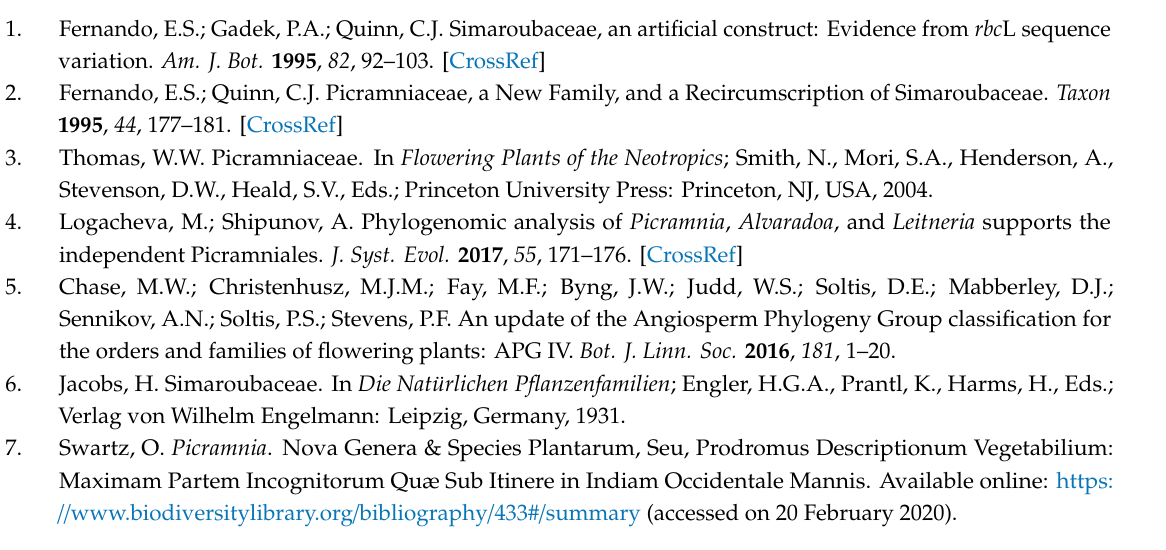
Table S1: Vouchers of Picramniaceae samples, Table S2: Working classification of Picramniaceae, Table S3: Genbank